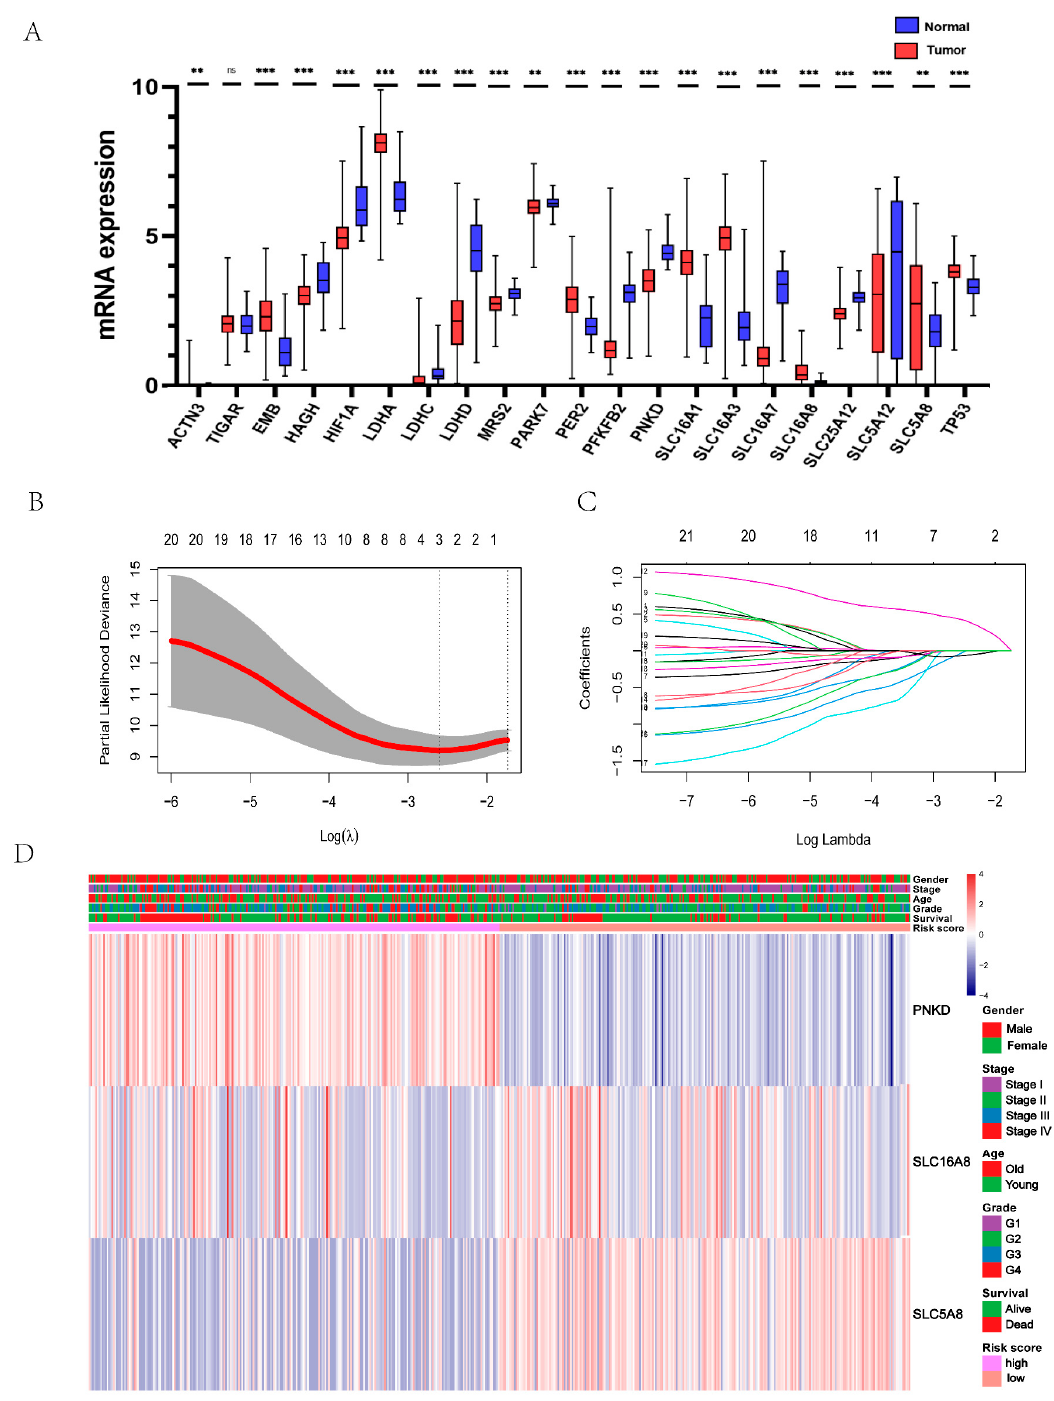
Figure 2. Establishment of prognostic model. ( A ) Differential mRNA expressions of lactate metabolism and transport related genes between clear cell renal cell carcinoma and normal re- nal tissue. ( B , C ) The tenfold cross-validated error and coefficients at varying levels of penalization plotted against the log (lambda) sequence for the least absolute shrinkage and selection operator analysis. ( D ) Heatmap illustrated the expression of the selected genes and the distribution of clini- copathologic factors in the TCGA cohort. ccRCC, clear cell renal cell carcinoma; TCGA, the cancer genome atlas. **: p < 0.01; ***: p < 0.001; ns: no